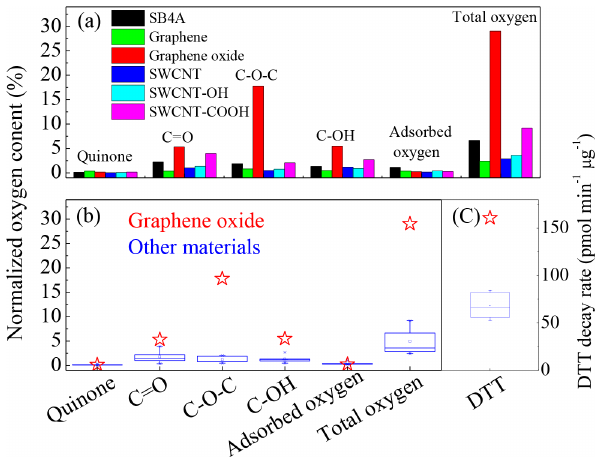
Figure 5. (a) Distribution of oxygen-containing species on the tested carbon nanomaterials; (b) comparison of oxygen-containing species and (c) DTT decay rate between graphene oxide and other carbon